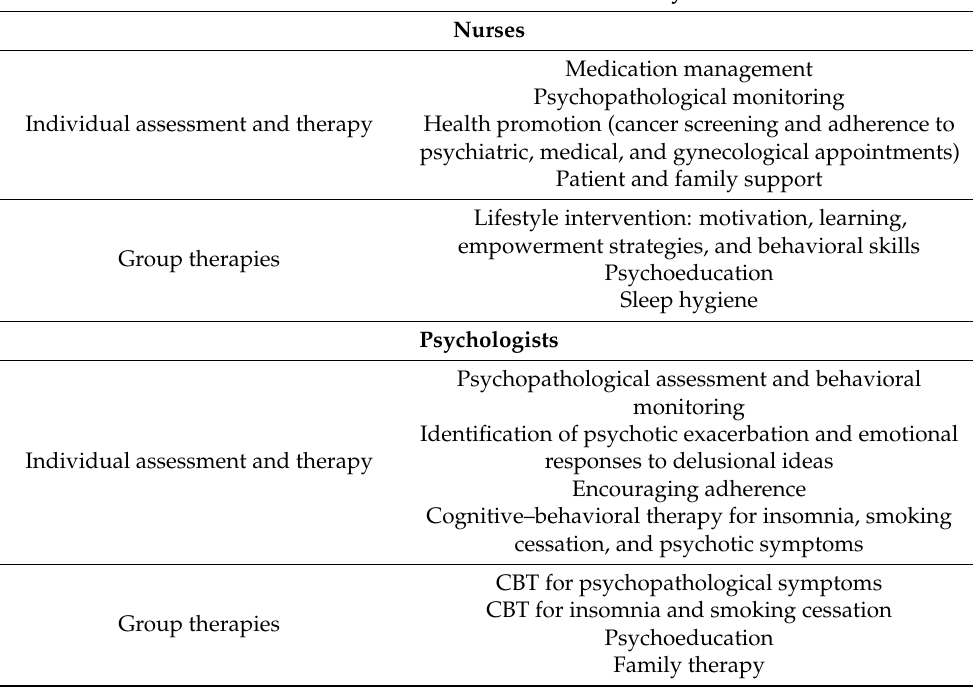
Table 3. Role of psychiatric nurses and psychologists in PHP for health promotion and prevention of mental and physical ill-health in women with